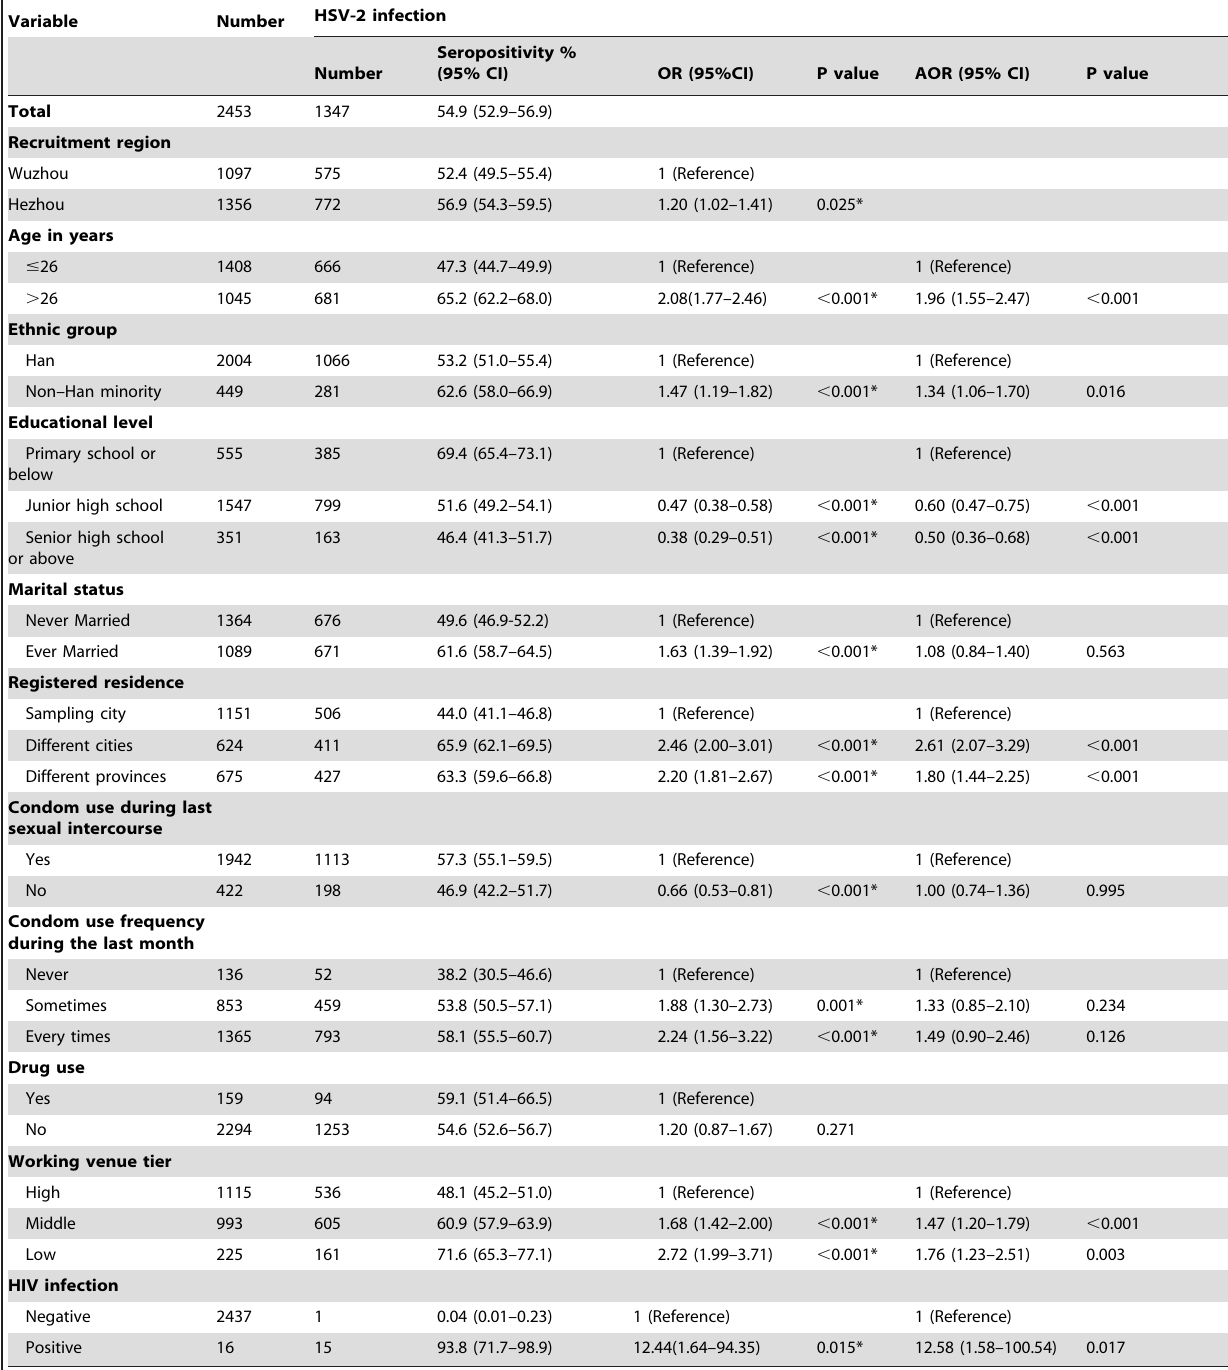
Table 1. Seropositivity and factors associated with HSV-2